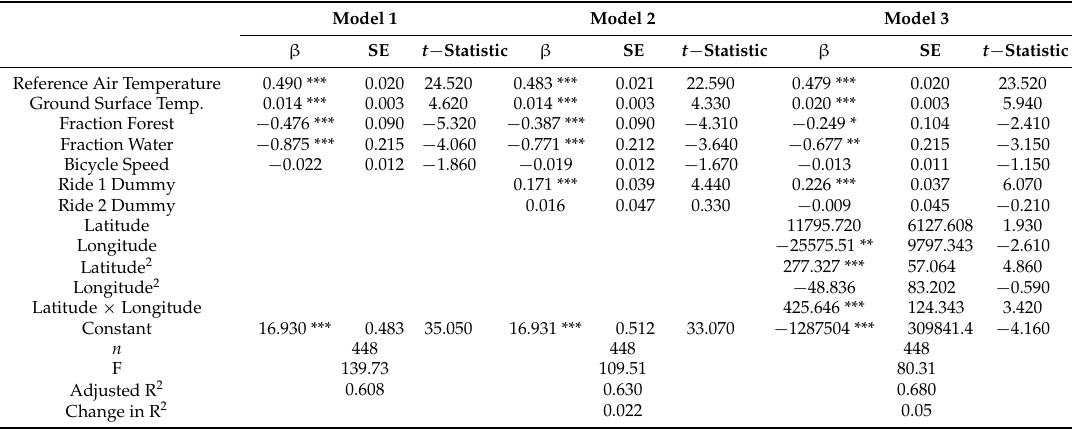
Table 5. Regression analysis for measured air temperature on the canal